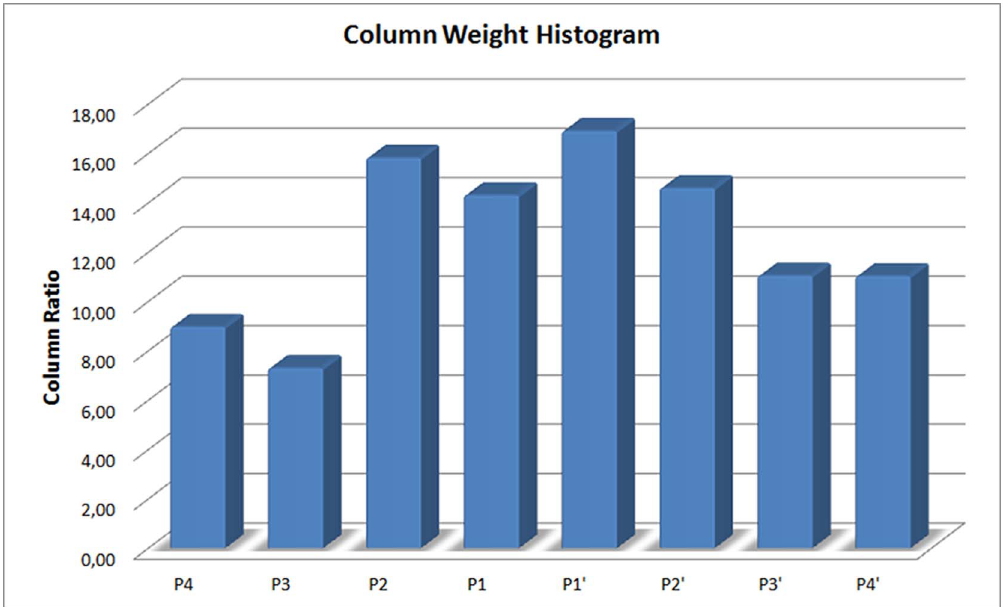
Figure 8. Column weights obtained from SVM rank values. These are the total weight percentages of attributes (positional weight matrix) per index obtained as a result of SVM ranking.